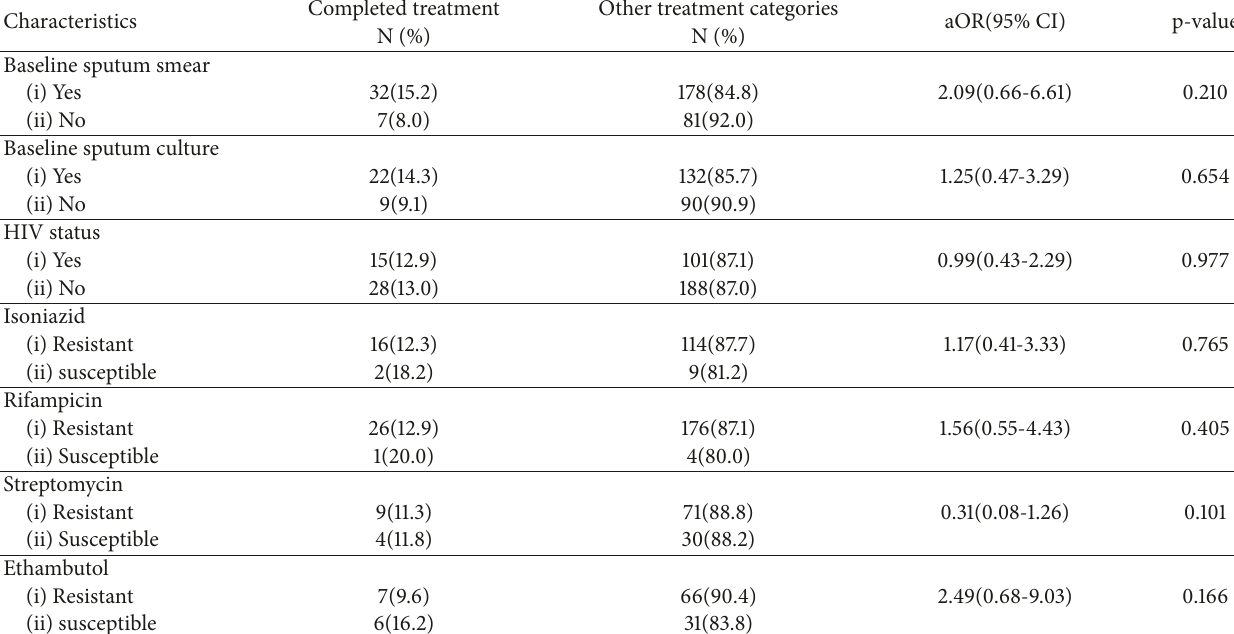
Table 5: Adjusted OR after multivariate analysis for predictors of treatment outcome of completed